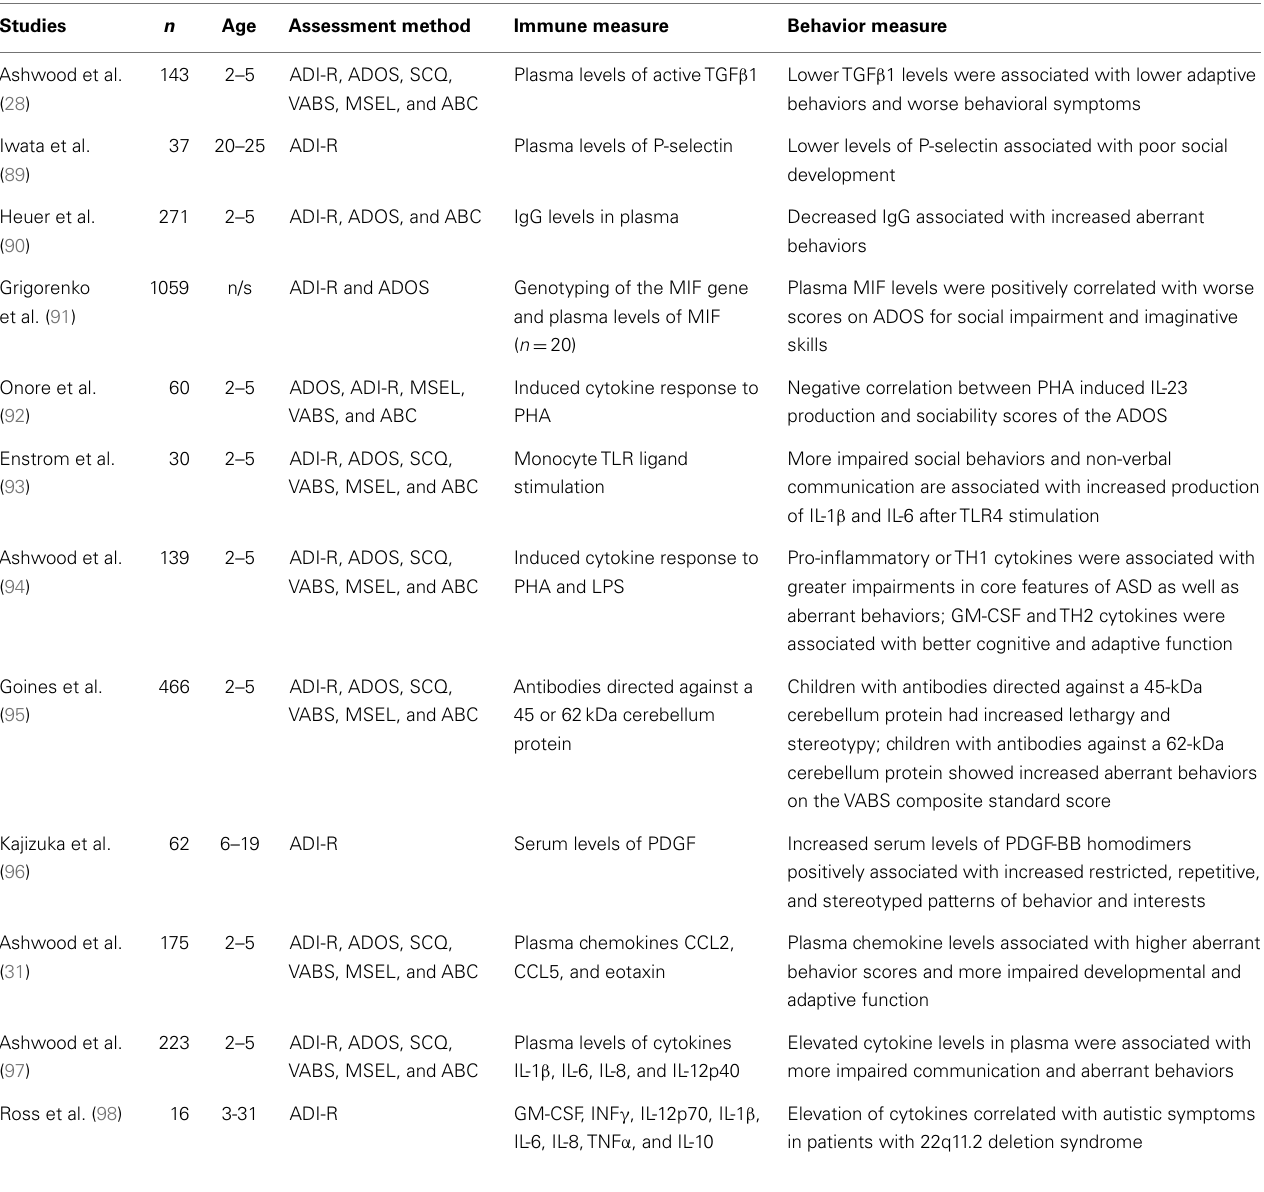
Table 2 | Behavior and immune functions inASD [adapted from Ref.